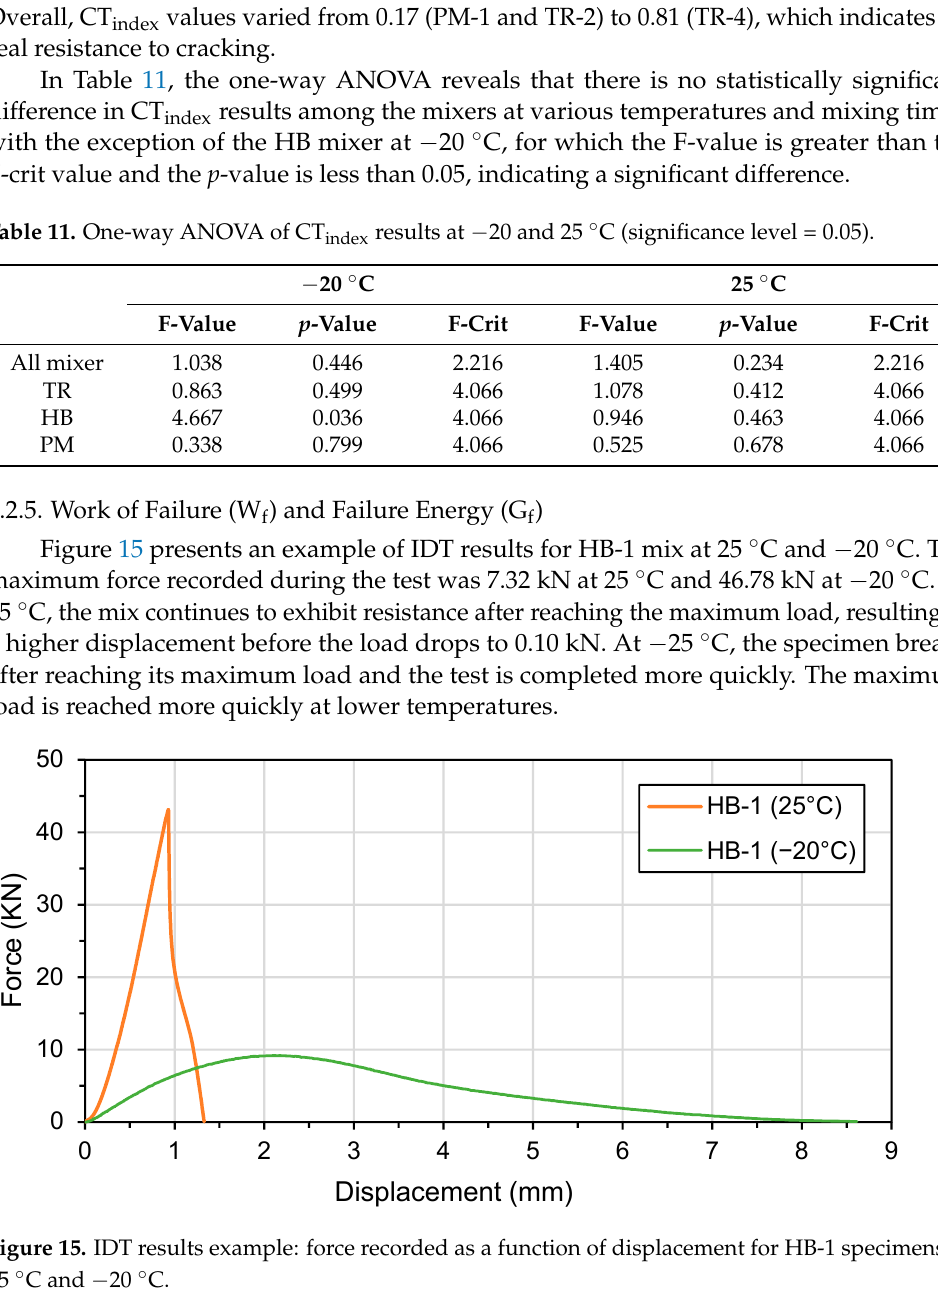
Figure 16. Work of failure (W f ) results at 25 °C ( n = 3) and − 20 °C ( n = 3). Figure 17. Failure energy (G f ) results at 25 °C ( n = 3) and − 20 °C ( n = 3).